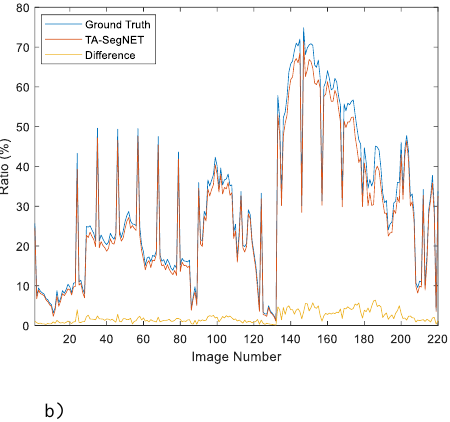
Fig. 11. Ground truth, segmented, and difference ratio a) for data set-1 b) for data set-2.